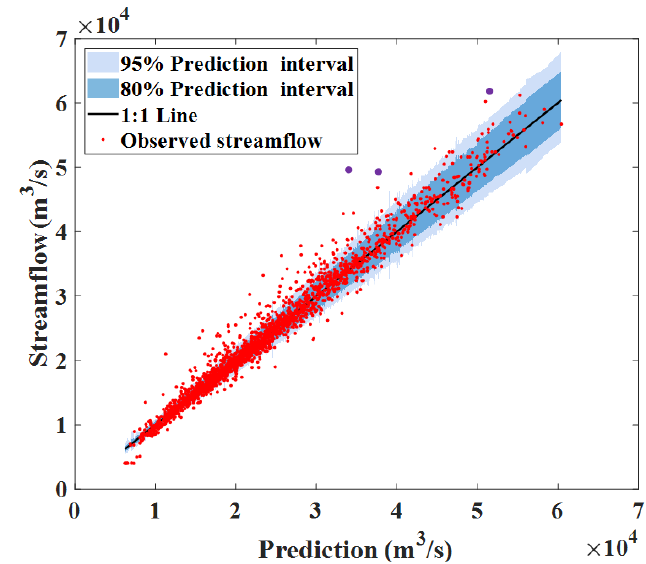
Figure 6. Uncertainty estimation of forecasts during whole test time (red dot, scatter point of predictions and observed streamflows; black line, 1:1 line; blue band, 80% credible interval; light blue band, 95% credible interval).